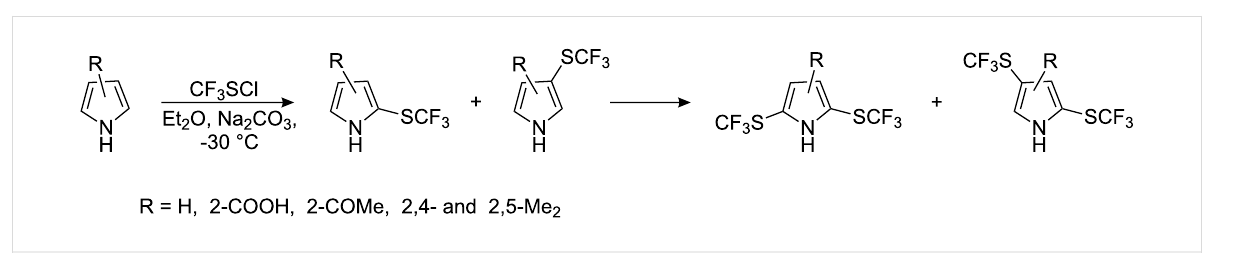
Scheme 14: Reactions of pyrroles with CF 3